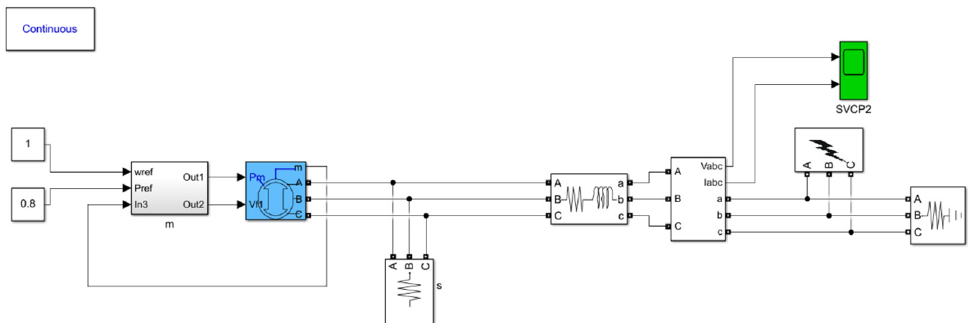
Figure 4. Simulation model in Matlab / Simulink.